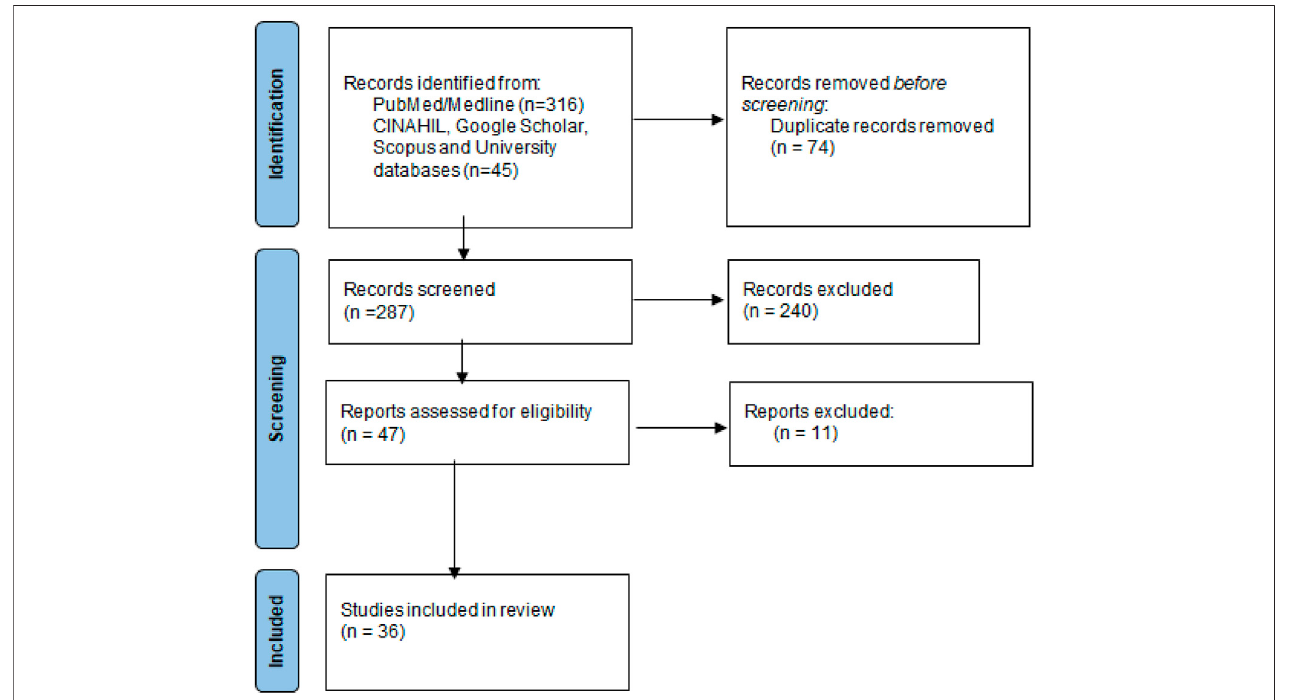
FIGURE 1 | Flow diagram of included studies. Legend: The PRIMSA diagram details our search and selection process applied during the review.